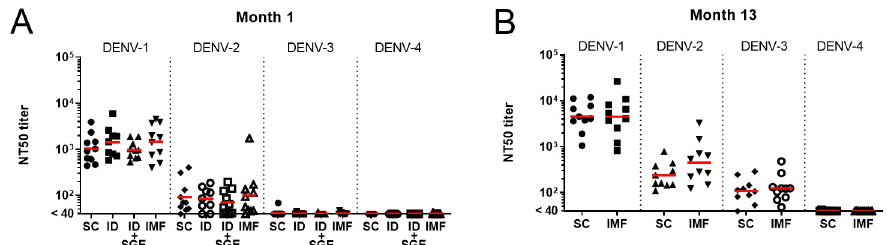
Fig 5. Neutralizing antibody titers following primary DENV-1 infection. Geometric mean NT50 titers (red bars) and individual data points for A) month 1 and B) month 13 post infection sera are shown for each of the four DENV serotypes. To compare IMF to the SC group, an ANOVA model was fitted on log 10 fold changes by including group, time, and group � time as fixed effects. Time was considered as a repeated factor with an unstructured matrix and heterogeneous variances between groups were assumed. Geometric means and geometric mean ratios and their respective 95% CIs were derived from this model. No adjustment for multiplicity was performed. No differences were found between groups at these time points for NT50 titer. n = 10 for each SC, ID+SGE, and IMF; n = 9 for ID. SC, subcutaneous; ID, intradermal; ID+SGE, intradermal + salivary gland extract; IMF, infectious mosquito